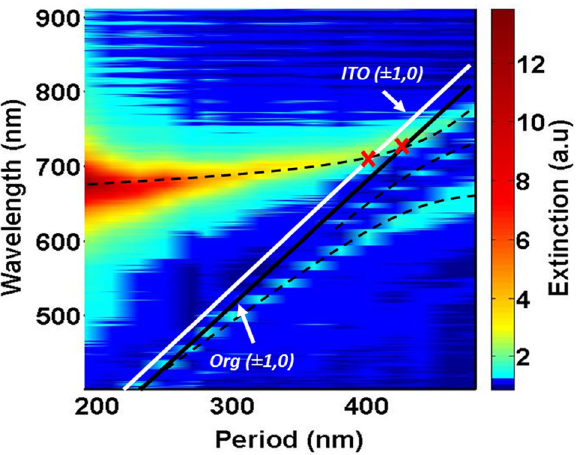
Figure 2. Extinction map intensity for Ag nanocylinders with a diameter of 100 nm as a function of the period and wavelength, and the corresponding (± 1, 0) Rayleigh anomalies orders in the media of the structure. The color bar on the right represents the extinction